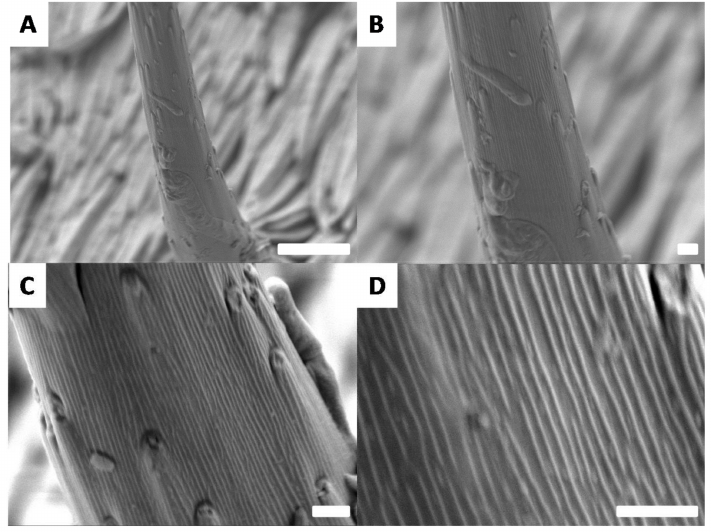
Figure 10. Scanning electron microscopy images showing the morphology of a G. orientalis microhair. Scale bars: 10 µ m ( A ); 1 µ m ( B – D